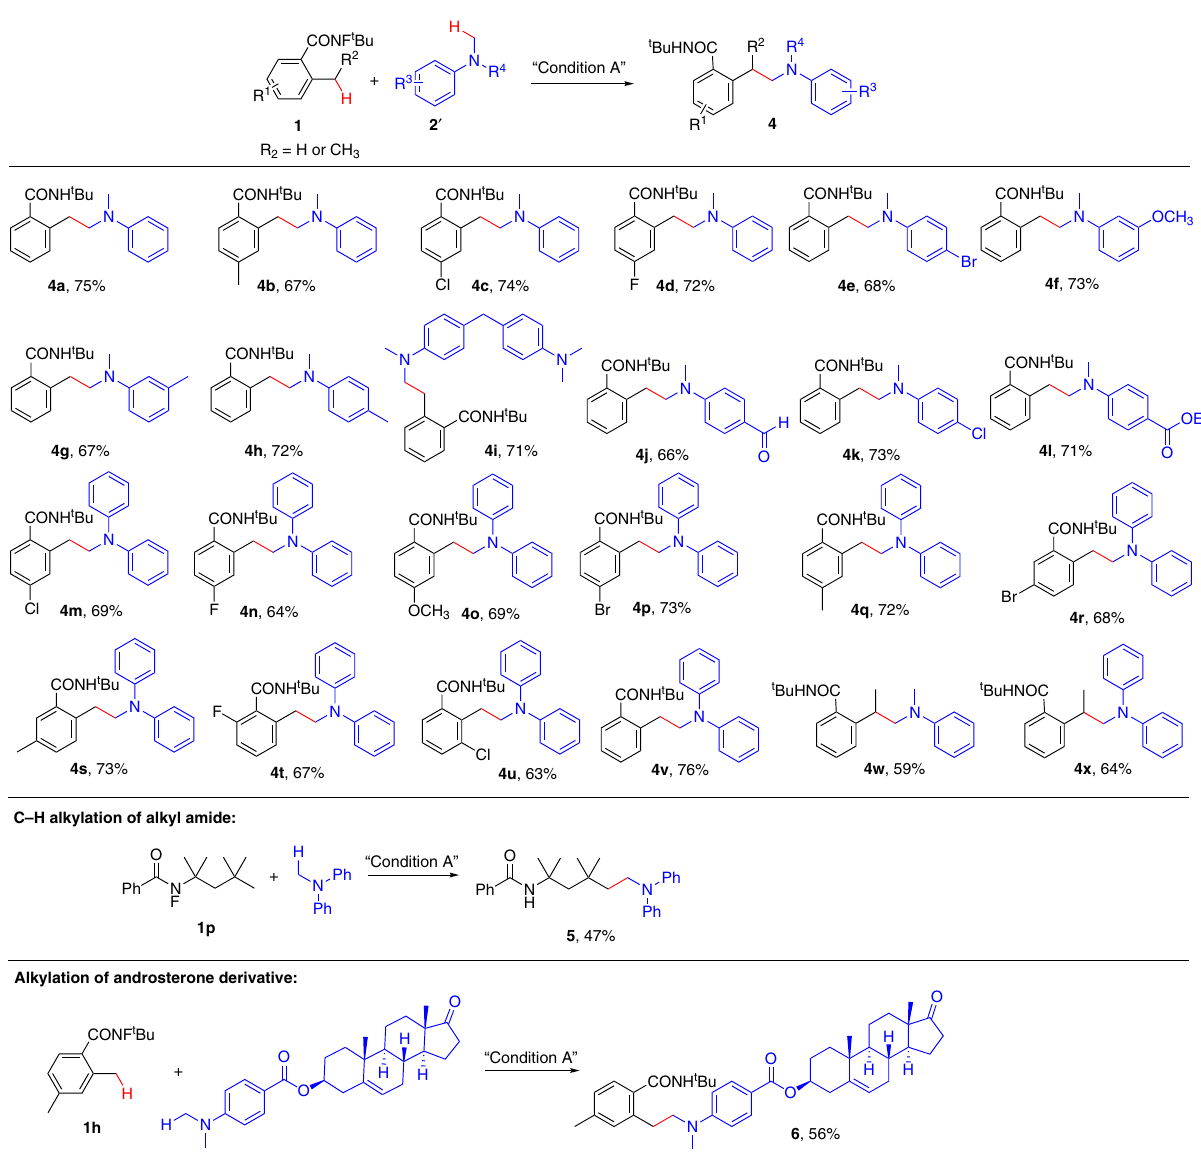
Fig. 4 Substrate scope of alkylation of tertiary amine α -C(sp 3 ) – H bonds. All reactions were conducted in 0.2 mmol scale. Yields referred to